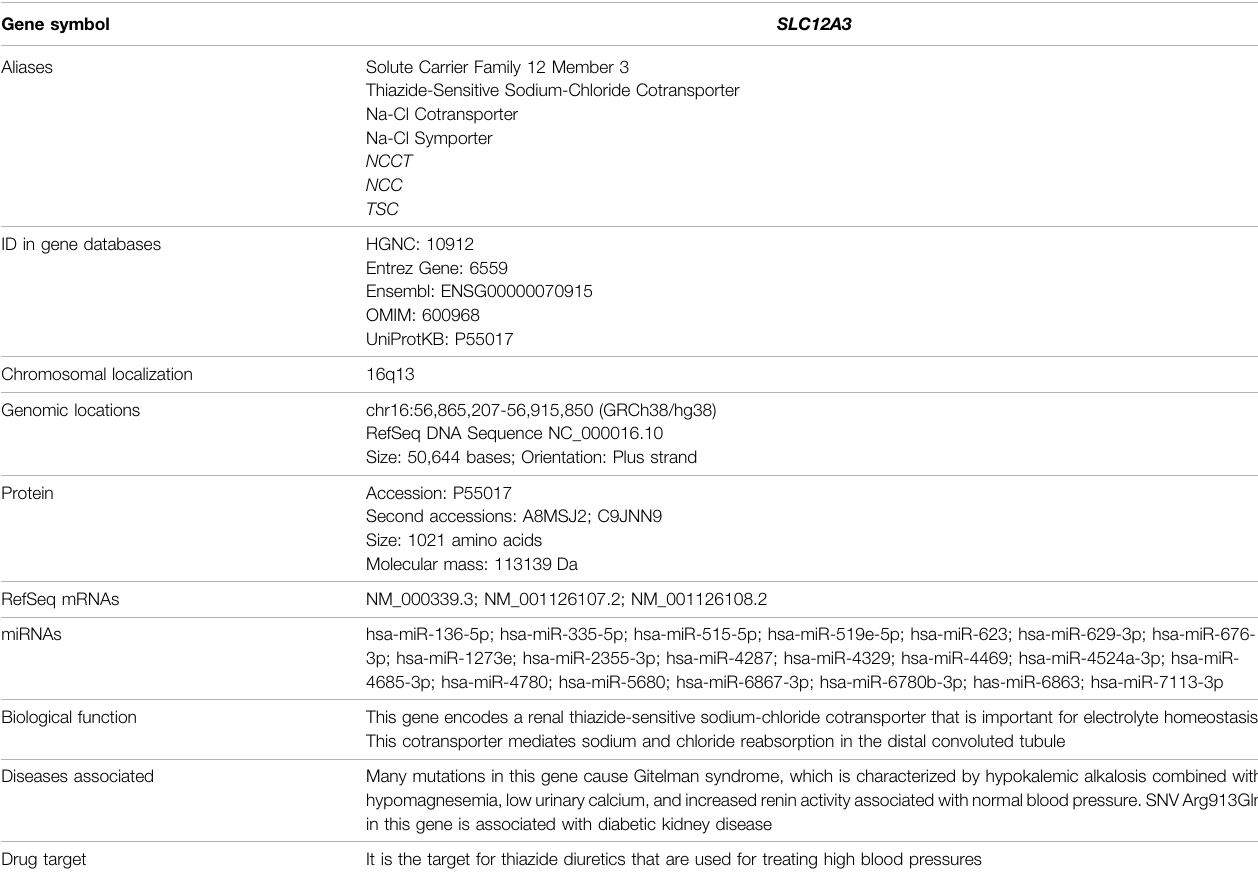
TABLE 1 | Bioinformatics of the SLC12A3 gene.